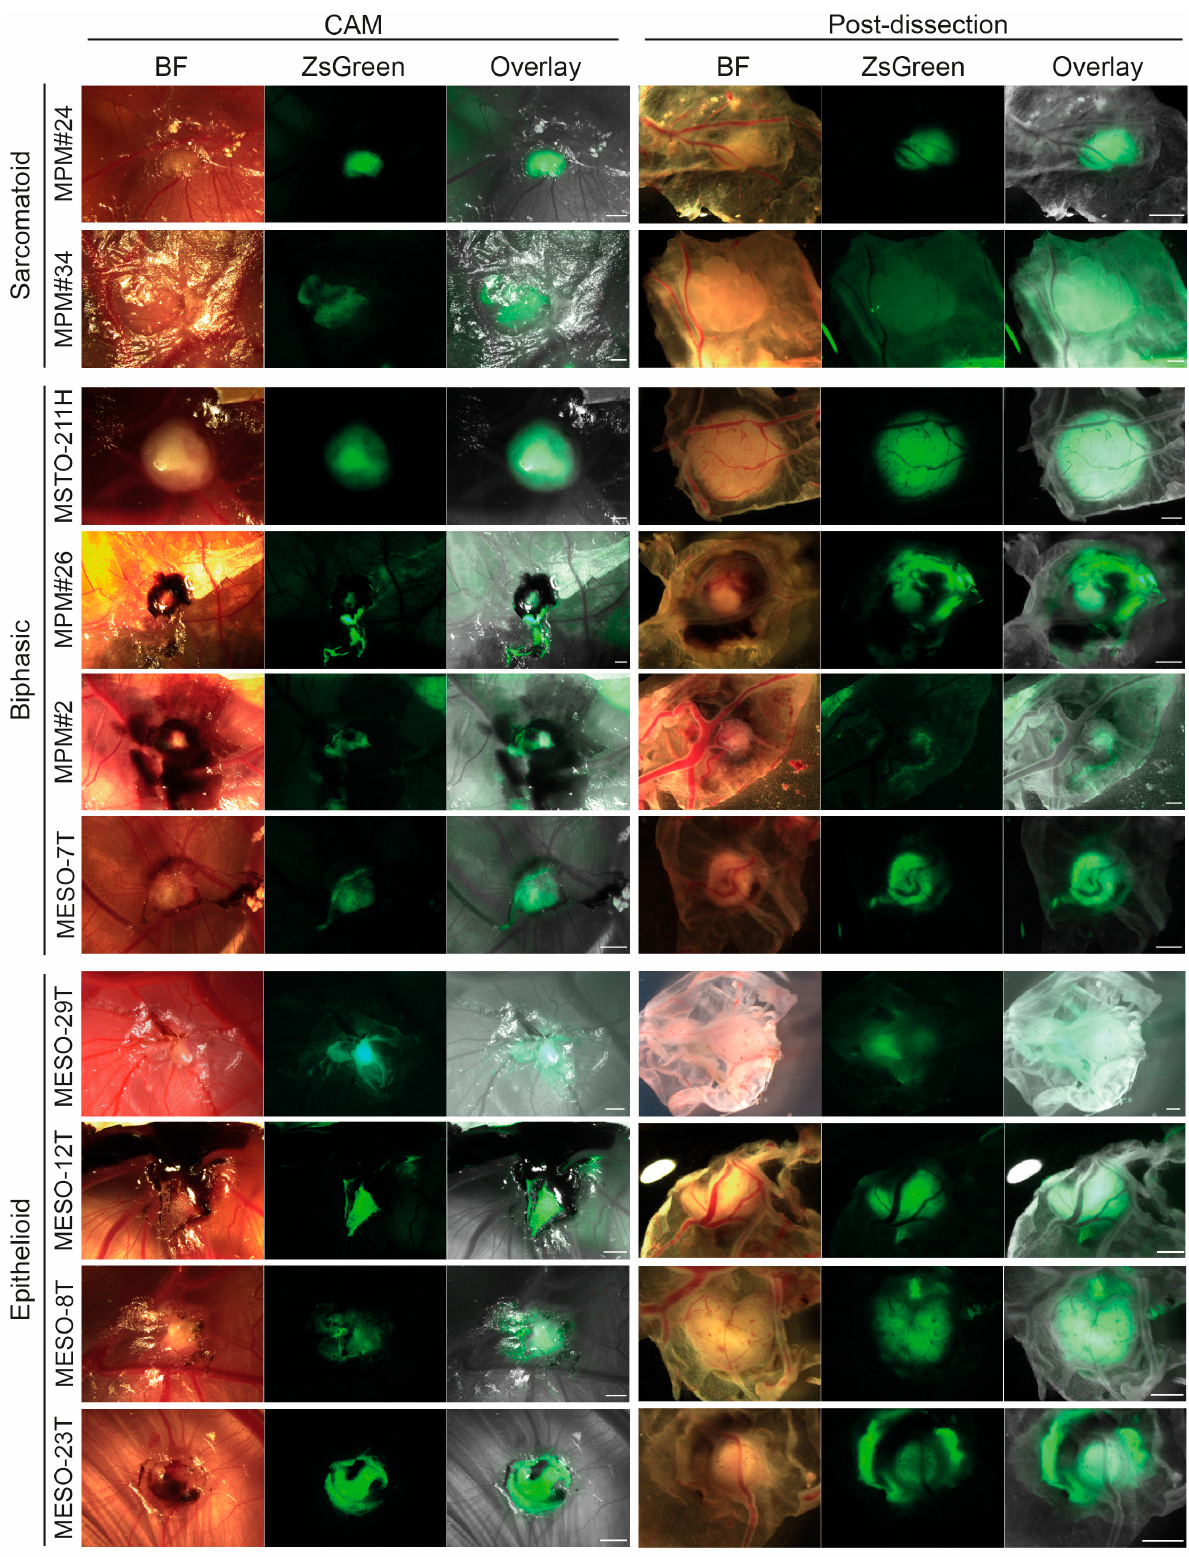
Figure 4. MPM cell lines all form vascularised tumour nodules on the CAM. Representative images of tumour nodules formed by each of the 10 MPM cell lines for the experiment shown in Figure 3. Nodules are shown in situ on the CAM in ovo (left) and post-dissection viewing the nodule from beneath (right). Scale bar 1 mm. BF, bright field.